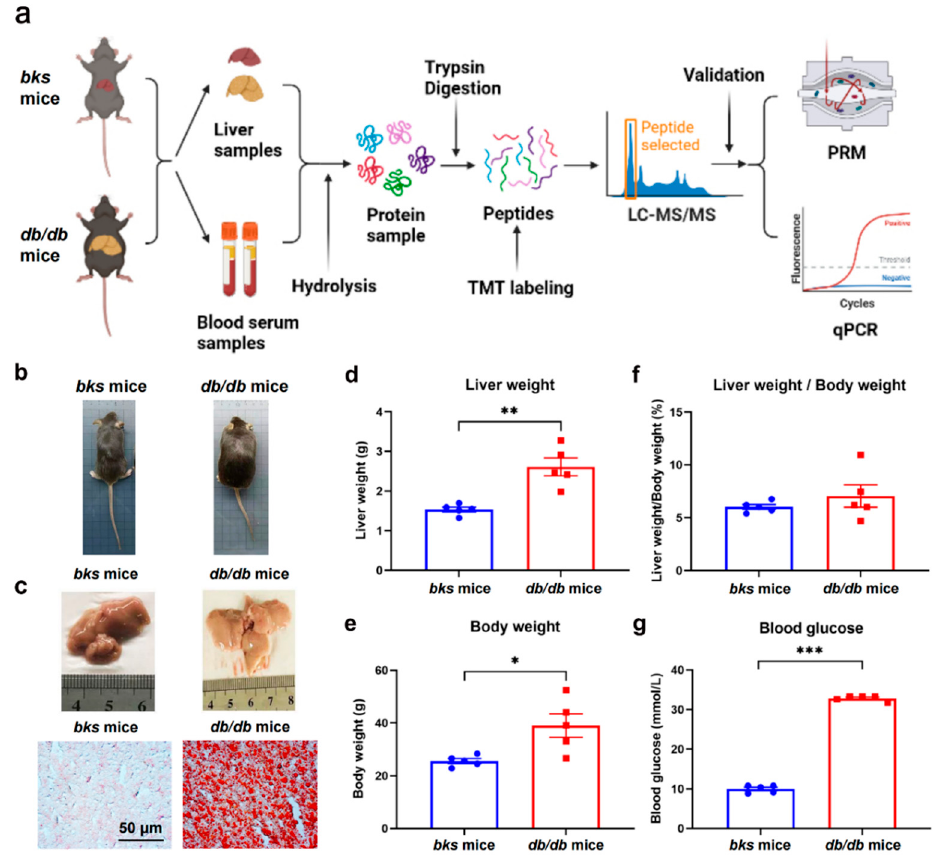
Figure 1. Study workflow and the validation of the genetic NAFLD mouse model. ( a ) Workflow chart; ( b ) Representative phages of db / db and bks mice ( n = 5); ( c ) Representative liver phages and the corresponding Oil Red O staining of bks and db / db mice; ( d ) Liver weight, ( e ) body weight, ( f ) ratios of liver and body weight and ( g ) blood glucose of db / db mice and bks control group. Red dots represent bks mice and blue squares represent db/db mice. * p < 0.05; ** p < 0.01; *** p < 0.001.